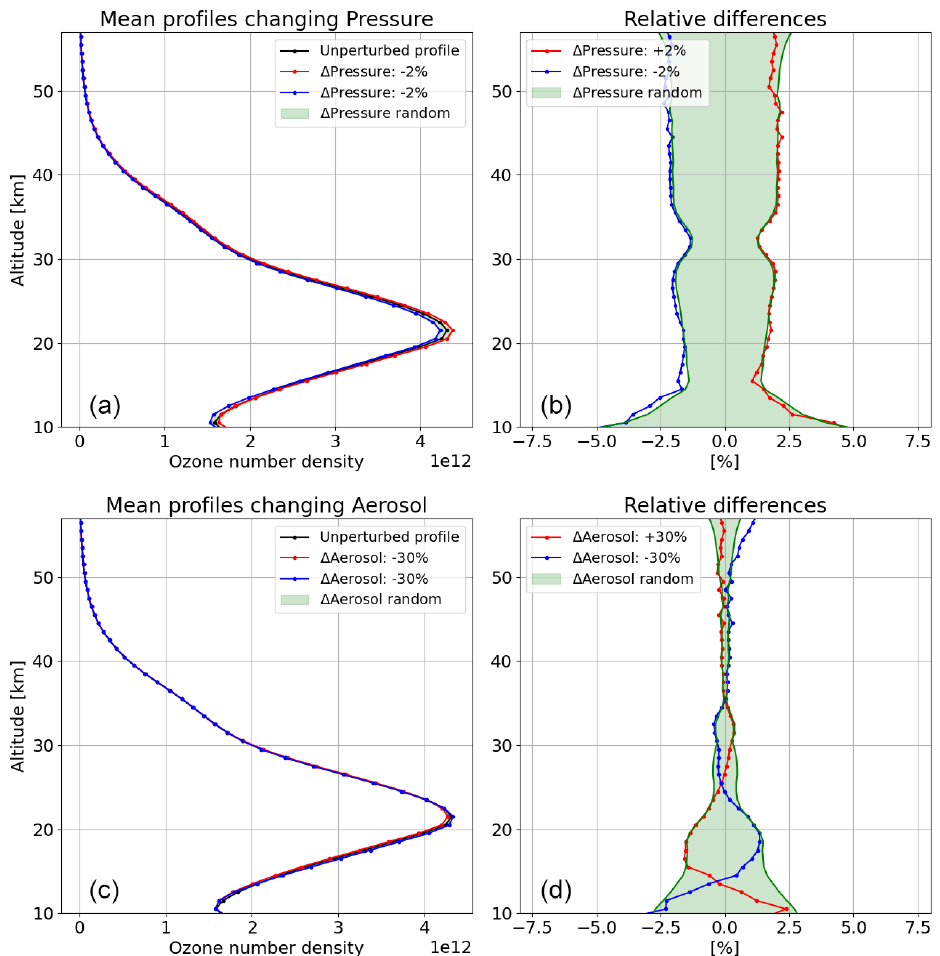
Figure 5. In panels (a) and (c) , the unperturbed ozone profile is shown together with the mean ozone profiles obtained by a Monte Carlo approach by perturbing the forward simulation pressure (a, b) and aerosol extinction (c, d) by 2% and 30%, respectively. The green shaded area shows (barely visible) the standard deviation of the 50 profiles obtained with the second approach. In panels (b) and (d) , σ x, pert_fix and σ x, pert_rand are shown in relative values for the respective